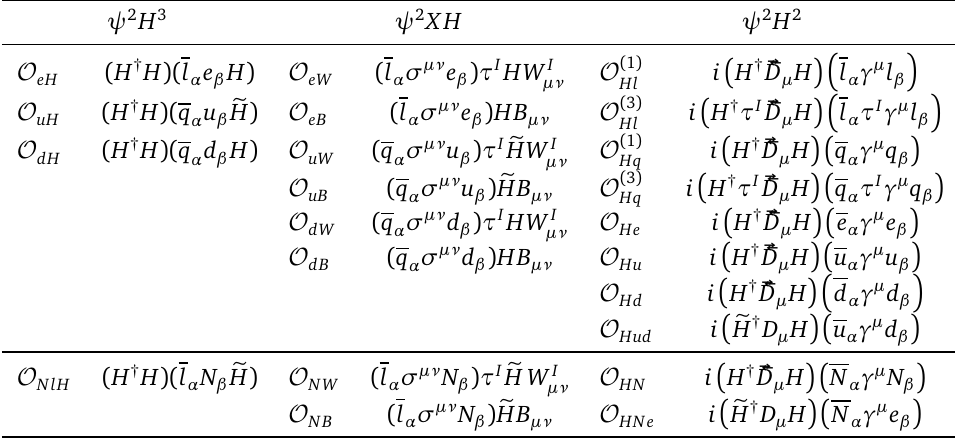
Table 2: Mixed fermion-boson D6 operators, giving rise to neutrino interactions, including only SM fields (upper) and including SM fields and right-handed sterile neutrino singlets (lower). Operator name conventions adapted from Ref. [ 48 ]